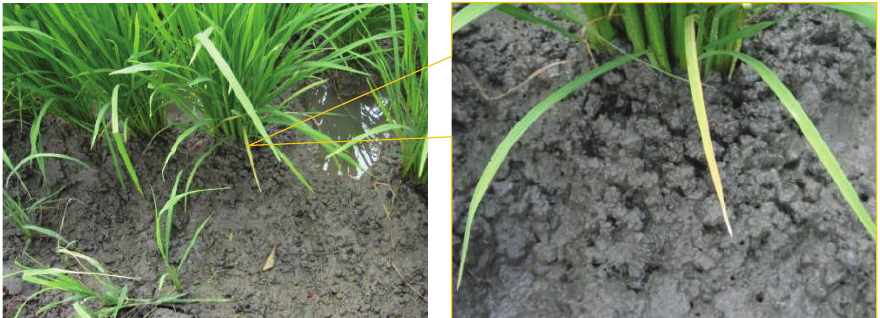
Figure 6: Earthworm casts visible on the soil surface of a paddy field where the current system has been